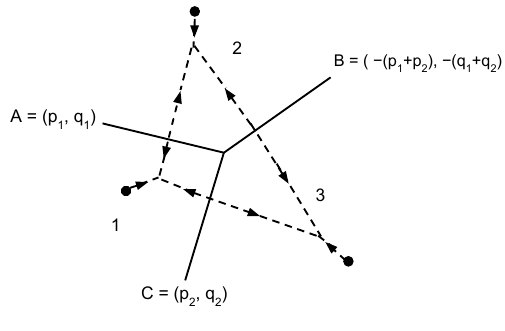
Figure 11 . There are three sectors of junctions allowed in the generic three-pole case.